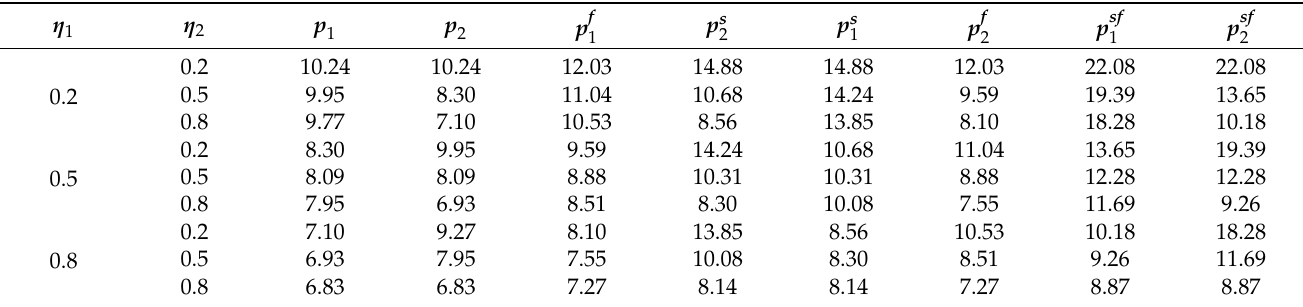
Table 1. Pricing varies with the degree of risk